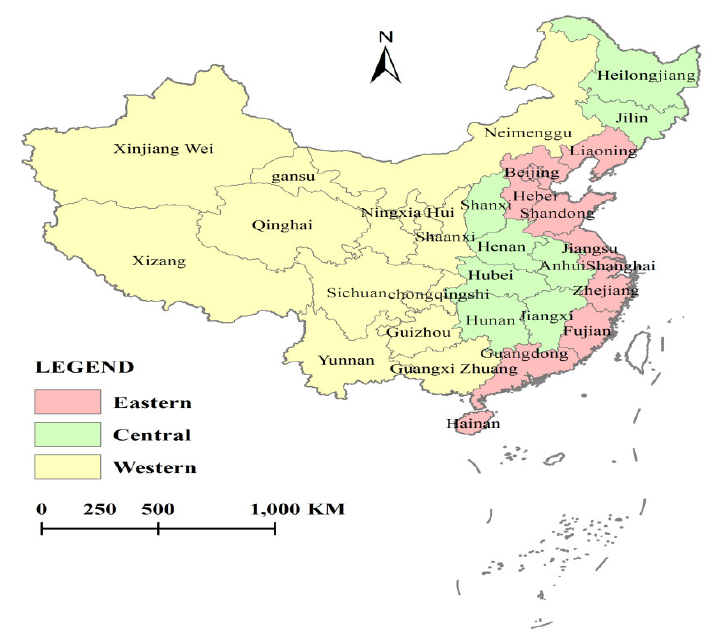
Figure 1. Distribution map of Eastern, Central and Western regions in China.